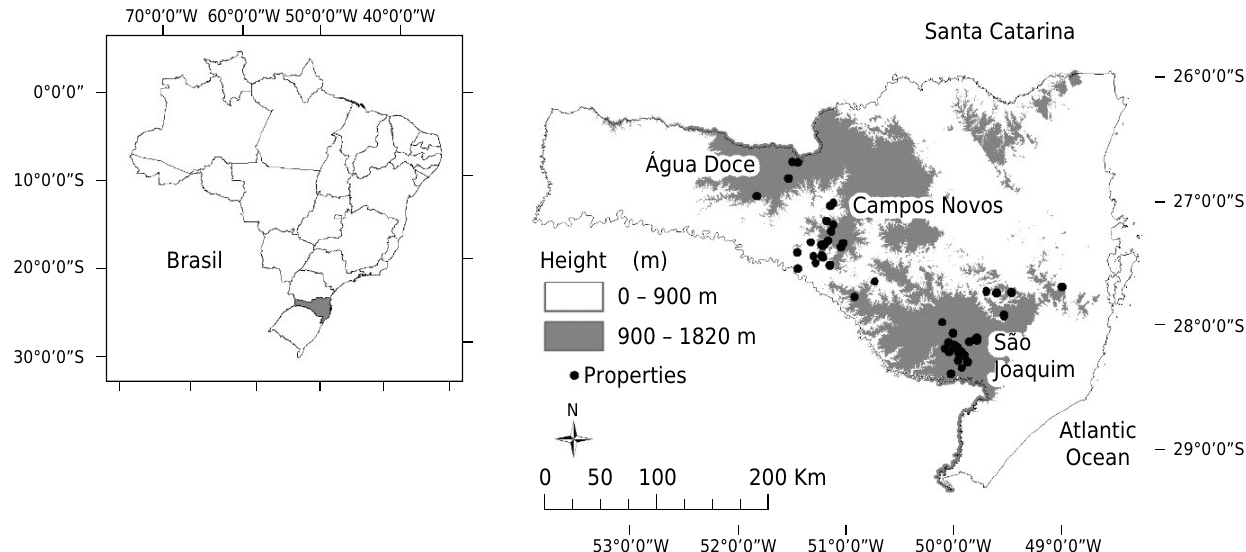
Figure 1. Altitude regions of the state of Santa Catarina, Brazil, and distribution of the soil profiles